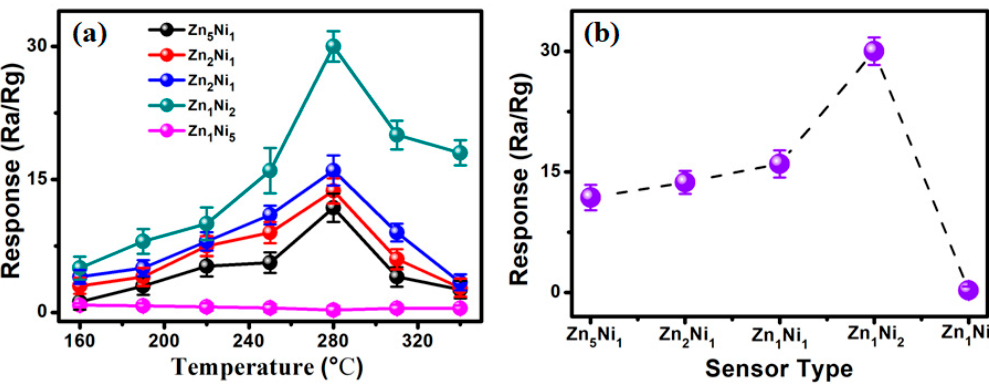
Figure 6. ( a ) Gas response of as-fabricated ZnO/NiO sensor toward 200 ppm NH 3 under different working temperatures. ( b ) Relationship of Response vs. Sensor type in presence of 200 ppm NH 3 at 280 °C.